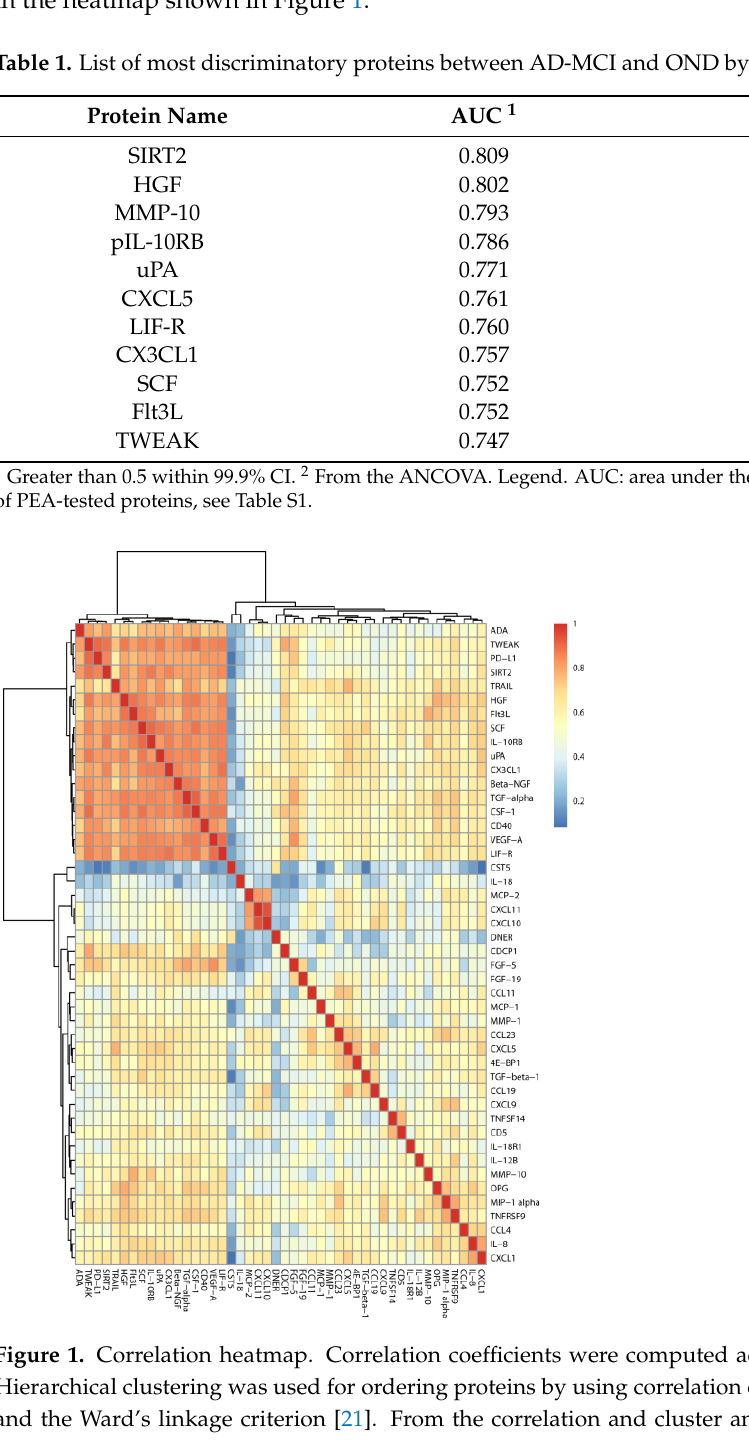
Table 1. List of most discriminatory proteins between AD-MCI and OND by univariate analysis. Protein Name